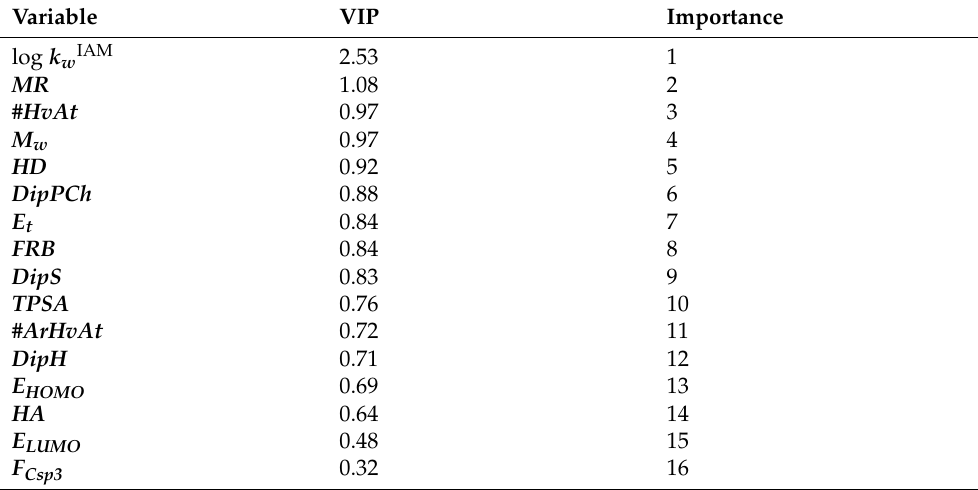
Table 2. VIP values for independent variables, model PLS1 .